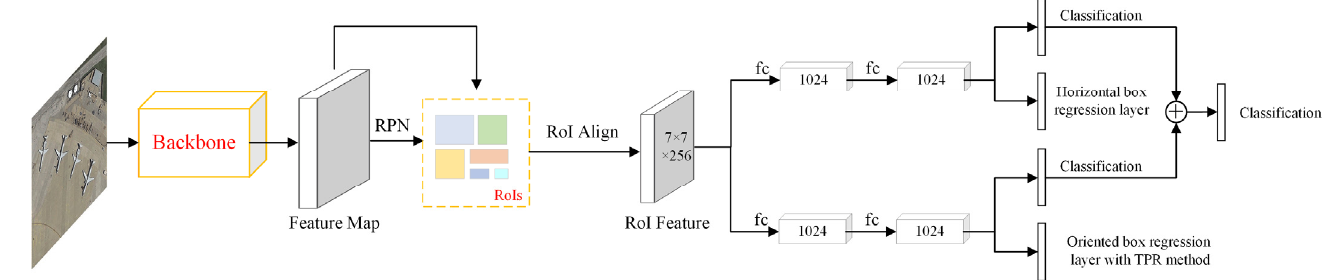
Figure 1. The object detection network structure diagram of the proposed TPR-R2CNN.